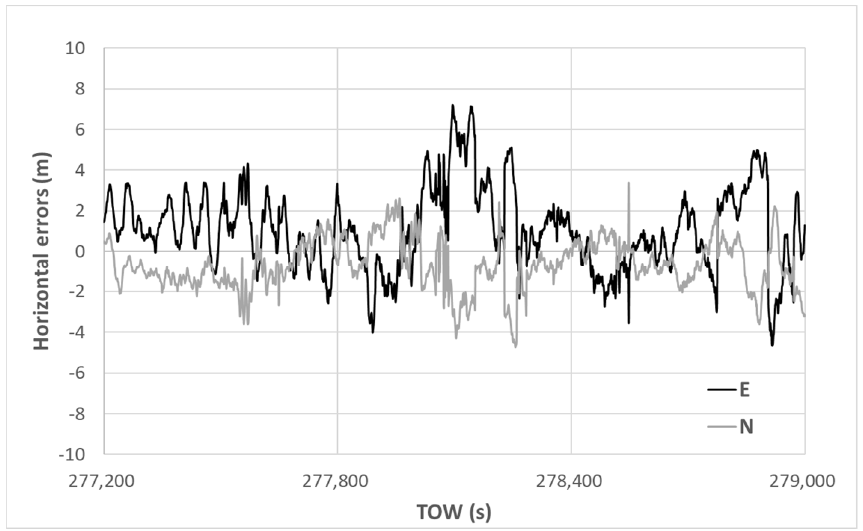
Figure 15 . DGNSS horizontal errors using new method. Figure 15. DGNSS horizontal errors using new